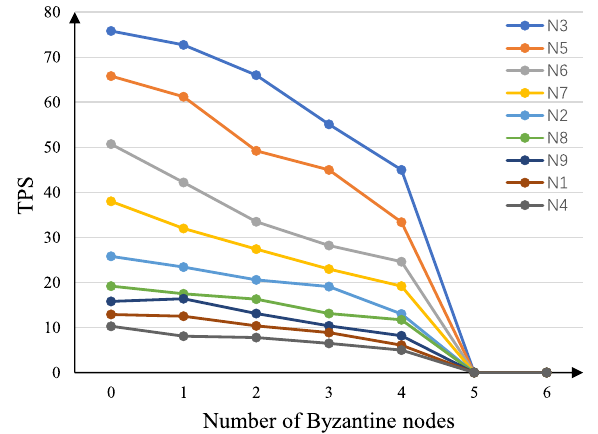
Fig. 5 Comparisons on system throughput of the nine nodes